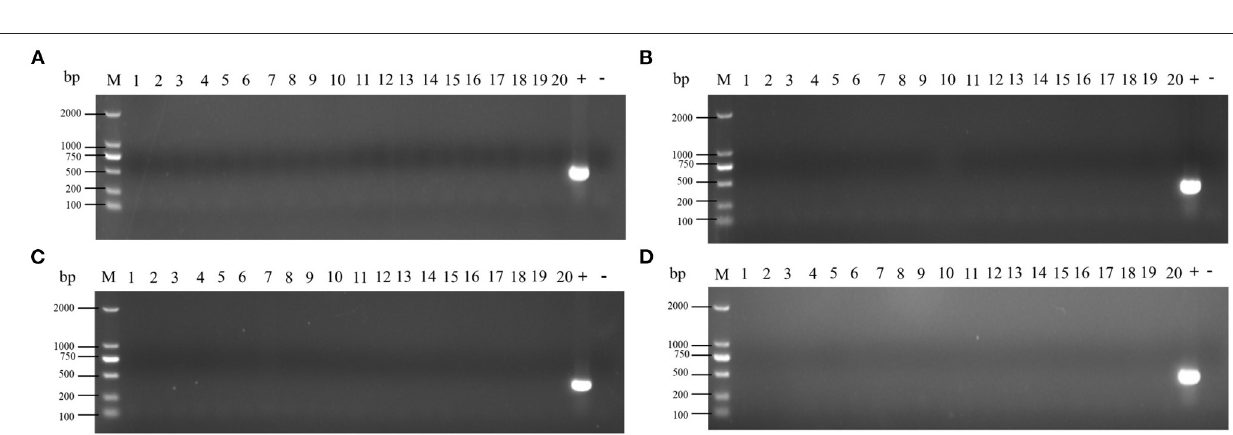
FIGURE 2 | Detection of Salmonella in the blood by PCR from ceftiofur groups. (A) Immunization 2 days after withdrawal: 1–10, control group; 11–20, ceftiofur group; + , positive control; –, negative control. (B) Immunization 3 days after withdrawal: 1–10, control group; 11–20, ceftiofur group; + , positive control; –, negative control. (C) Immunization 4 days after withdrawal: 1–10, control group; 11–20, ceftiofur group; + , positive control; –, negative control. (D) Immunization 5 days after withdrawal: 1–10, control group; 11–20, ceftiofur group; + , positive control; –, negative